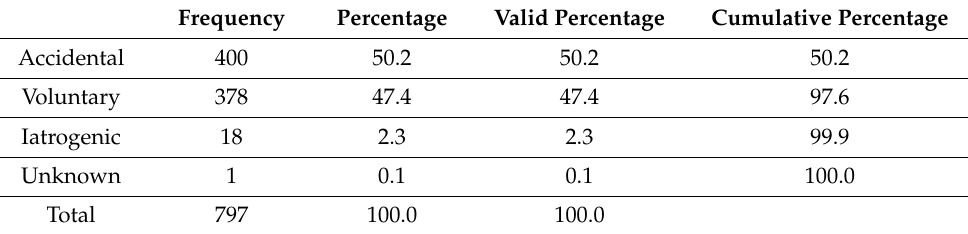
Table 3. Type of